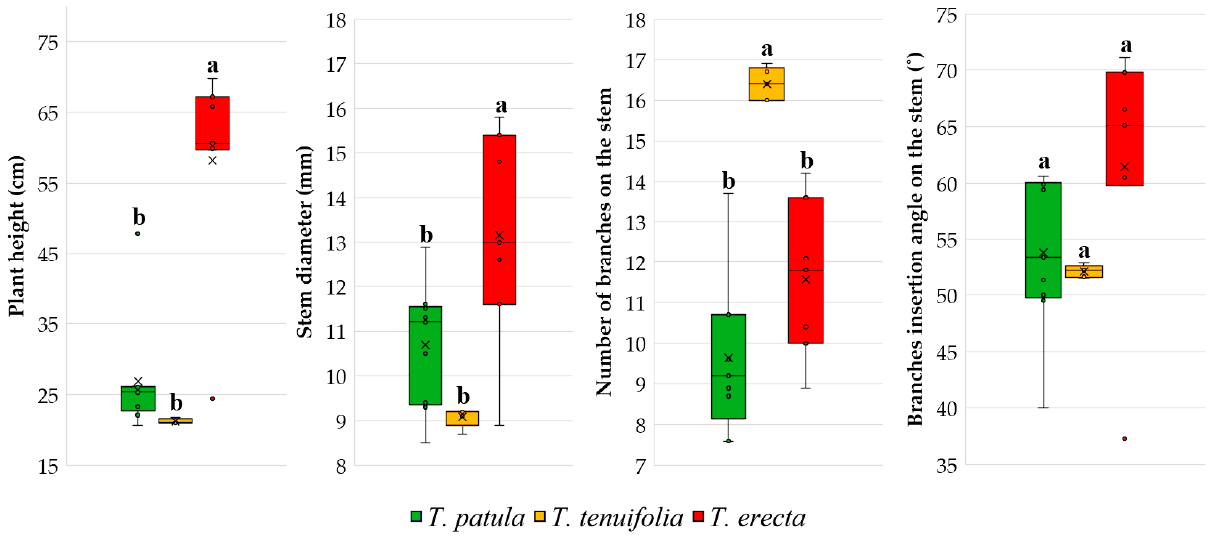
Figure 2. Main traits of the plants, based on the cultivars analysed in the three species of Tagetes . Each box plot represents minimum, lower quartile, median, upper quartile, and maximum values; in addition, the mean of the data is symbolised with a ‘ ✕ ’ into the boxplot. Different letters among boxplots indicate statistically significant differences for the respective trait at a significance level of p < 0.05 (Duncan test). Table 3. Main traits of the flowers, number of fruits per plant and their coefficient of variation for the Tagetes